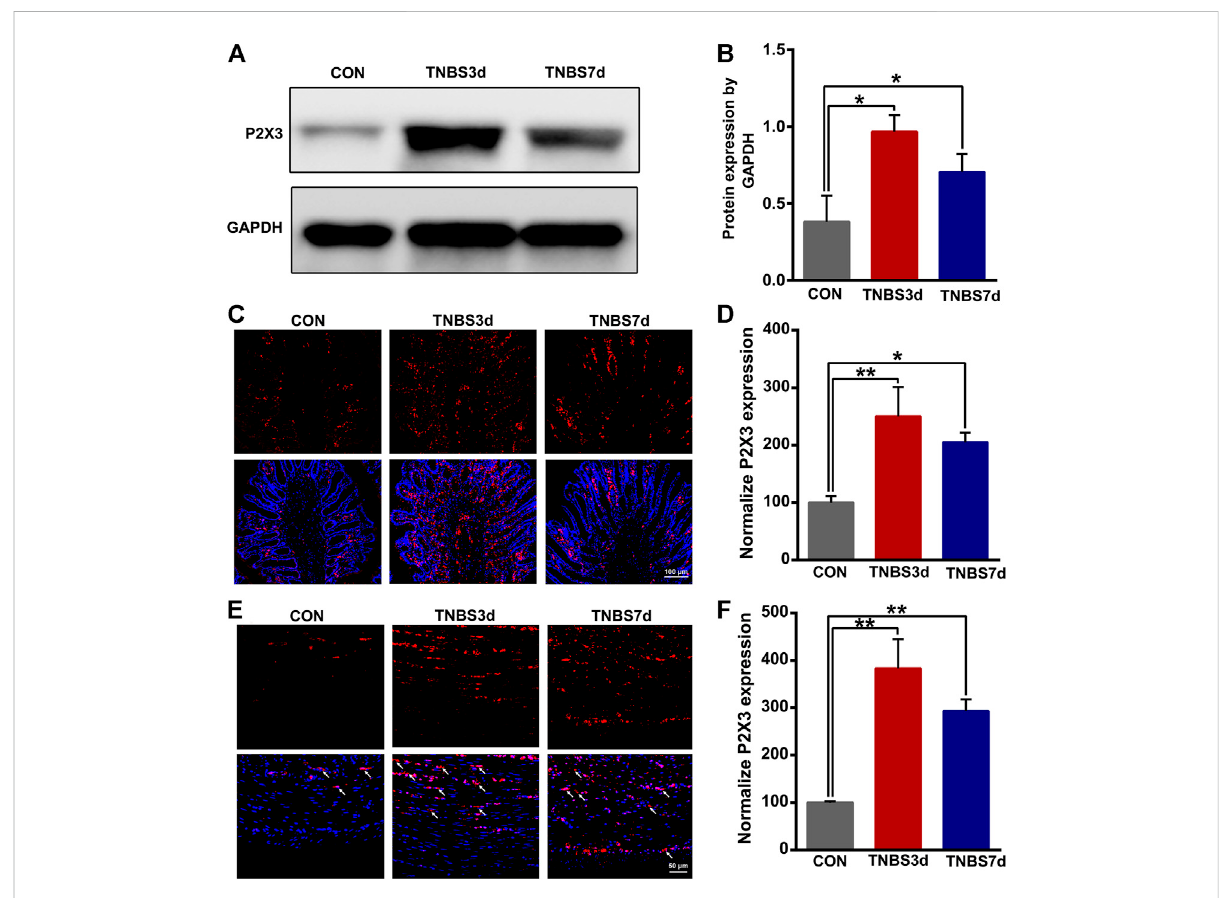
FIGURE 2 TNBS-induced colitis increased the P2X3 expression in the distal colon. (A – B) Western blotting showed that TNBS-induced colitis signi fi cantly increased the protein expression of the P2X3 receptor in the distal colon. n = 3 for each group. (C – D) P2X3 immunoreactivity in the submucosal plexus of the distal colon showed a signi fi cant increase in colitis at days 3 and 7 post-TNBS compared to the control group. Bar = 100 μ m; n = 4 for each group. (E – F) P2X3 immunoreactivity in the muscular layer of the distal colon showed that TNBS-induced colitis signi fi cantly increased P2X3 expression compared to the control group. Bar = 50 μ m; n = 4 for each group. * p < 0.05 and ** p < 0.01 by one-way ANOVA followed by Newman – Keuls post hoc